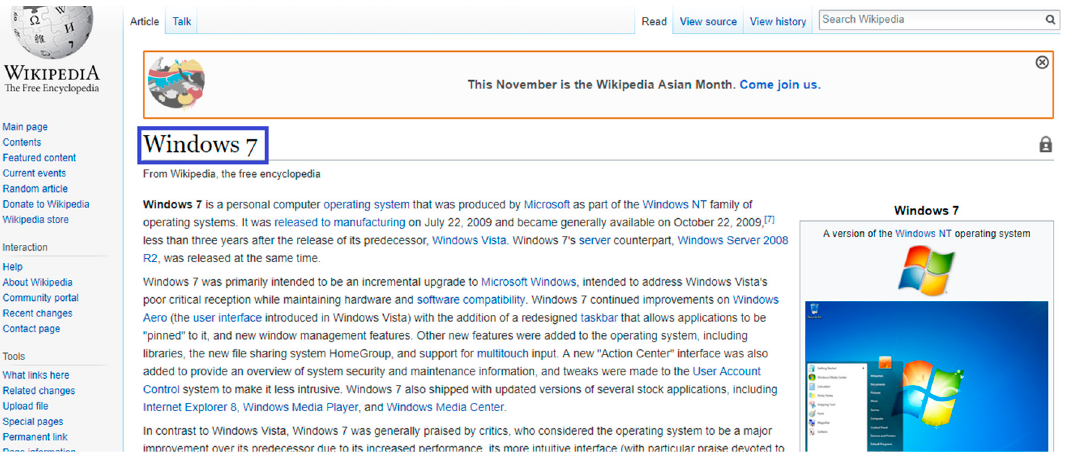
Figure 3. Verification of compound nouns (Continued).